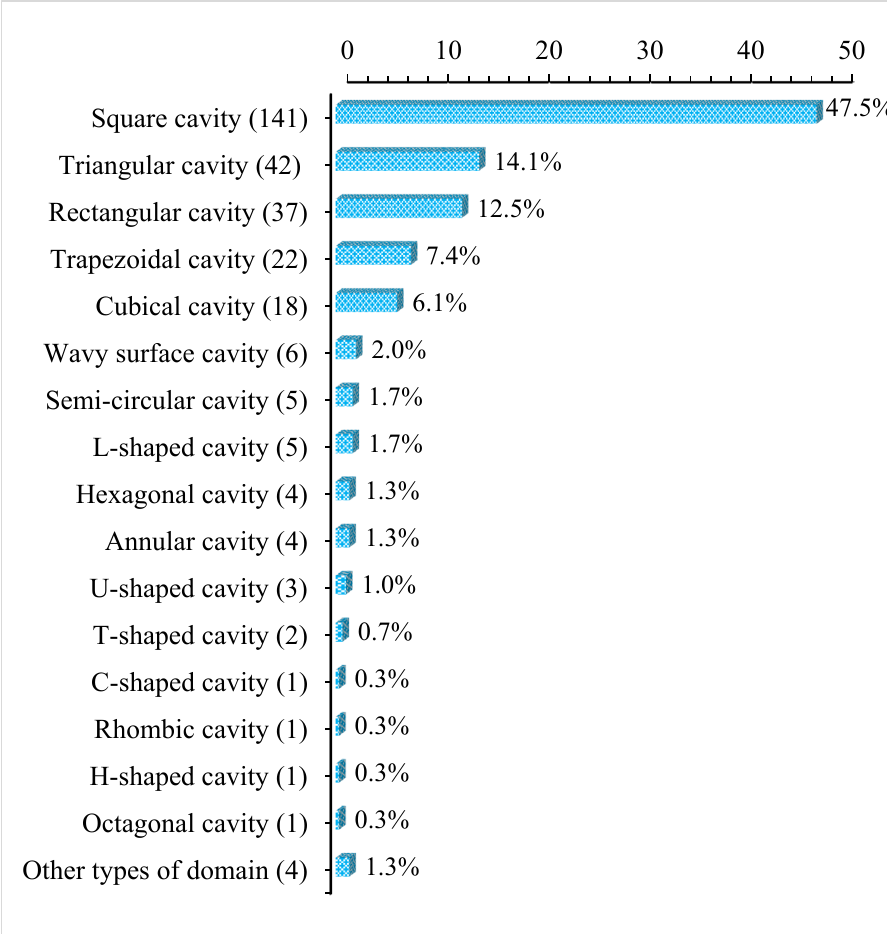
Figure 3. Percentage of different types of cavities.